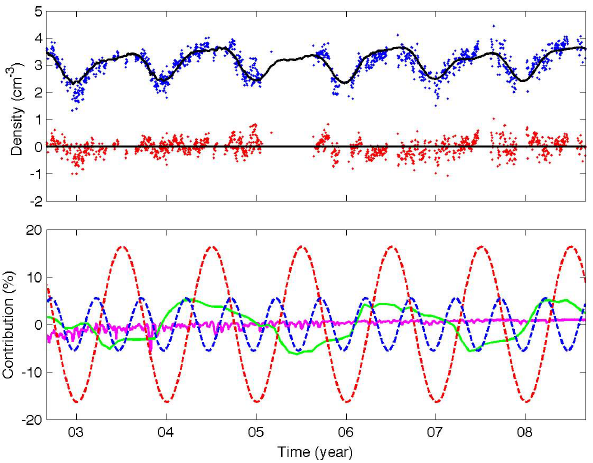
Fig. 18. An example of the NO 2 number density fitting at 30km in the 40 ◦ N–50 ◦ N latitude band. Time axis unit is day. In the upper panel GOMOS measurements are shown by the blue dots and the fit by the black line. The residual is shown by red dots. All three scaled by scaled by 10 9 cm − 3 . In the lower panel the identifications are: annual ( a 1 and b 1 contributions): dashed red, Semi-annual ( a 2 and b 2 contributions): dashed blue, QBO 1 ( q 1 and q 2 contributions): solid green, solar ( s ): solid magenta. The components have been scaled by a constant coefficient and given in %. The constant term itself has not been shown.